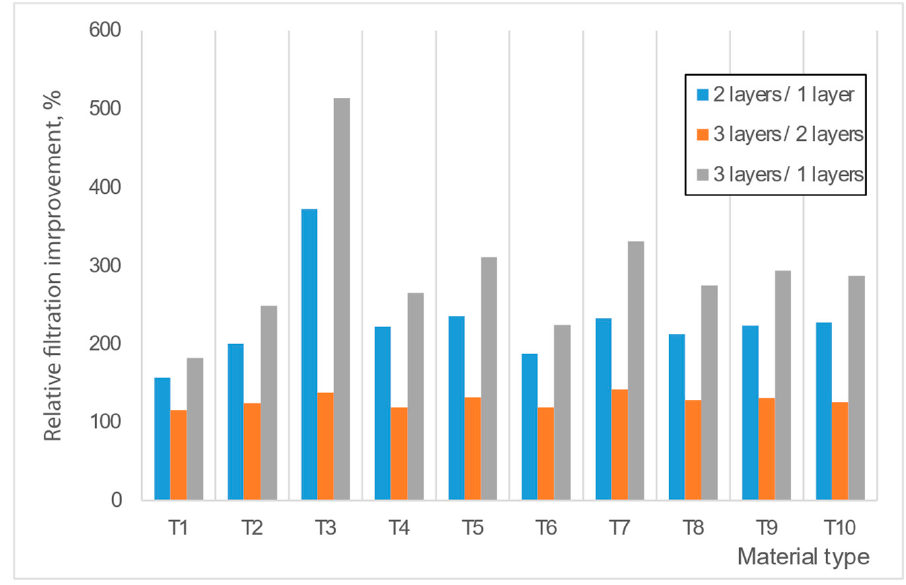
Figure 6. Improvement ratio over layer stacking. Table 4. Pearson coefficients of layer